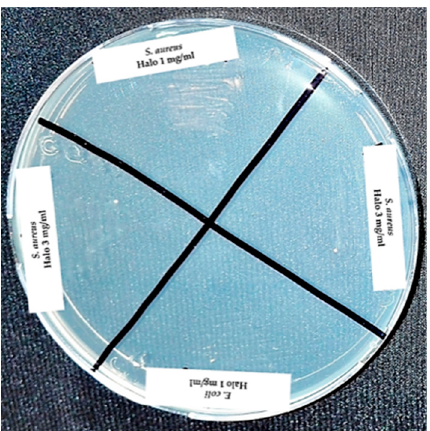
Figure 8. Seeding from the halos of inhibition for the strains of E. coli and S. aureus against nZH-Cu.